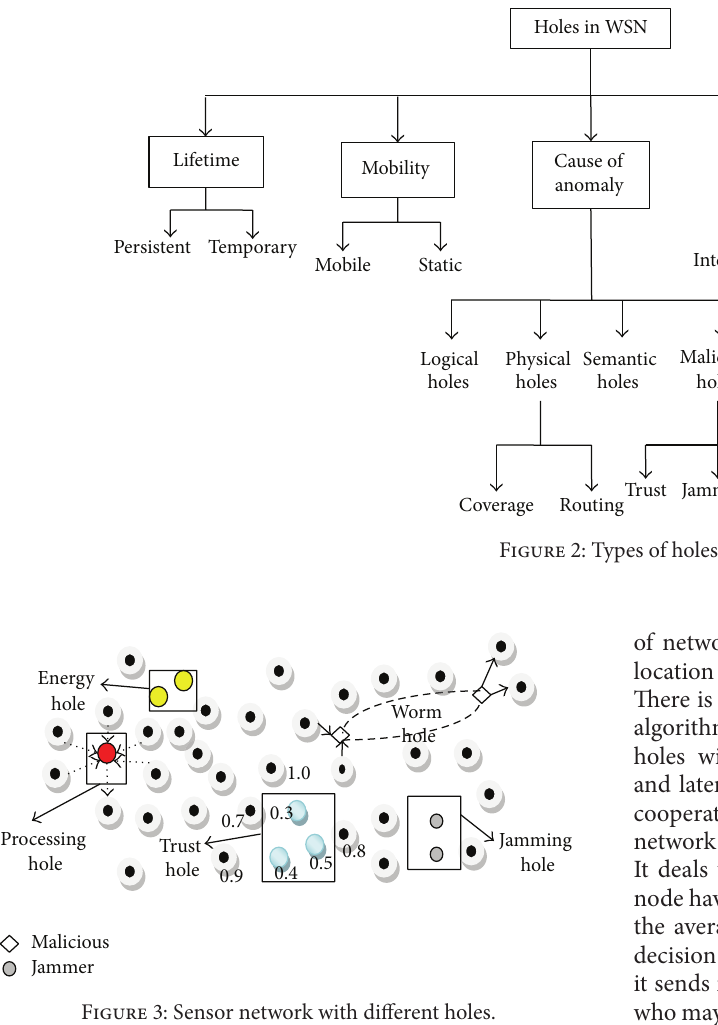
Figure 3: Sensor network with different